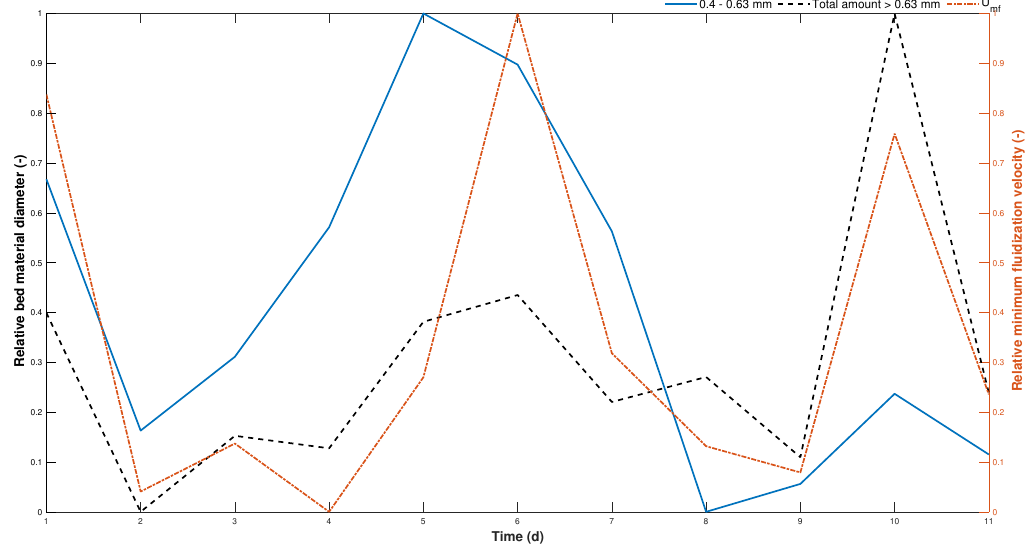
Figure 6. Detection of bed agglomeration: correlation between boiler minimum fluidization and increase of bed material (BM) and recirculated fines (RF) diameter, normalized